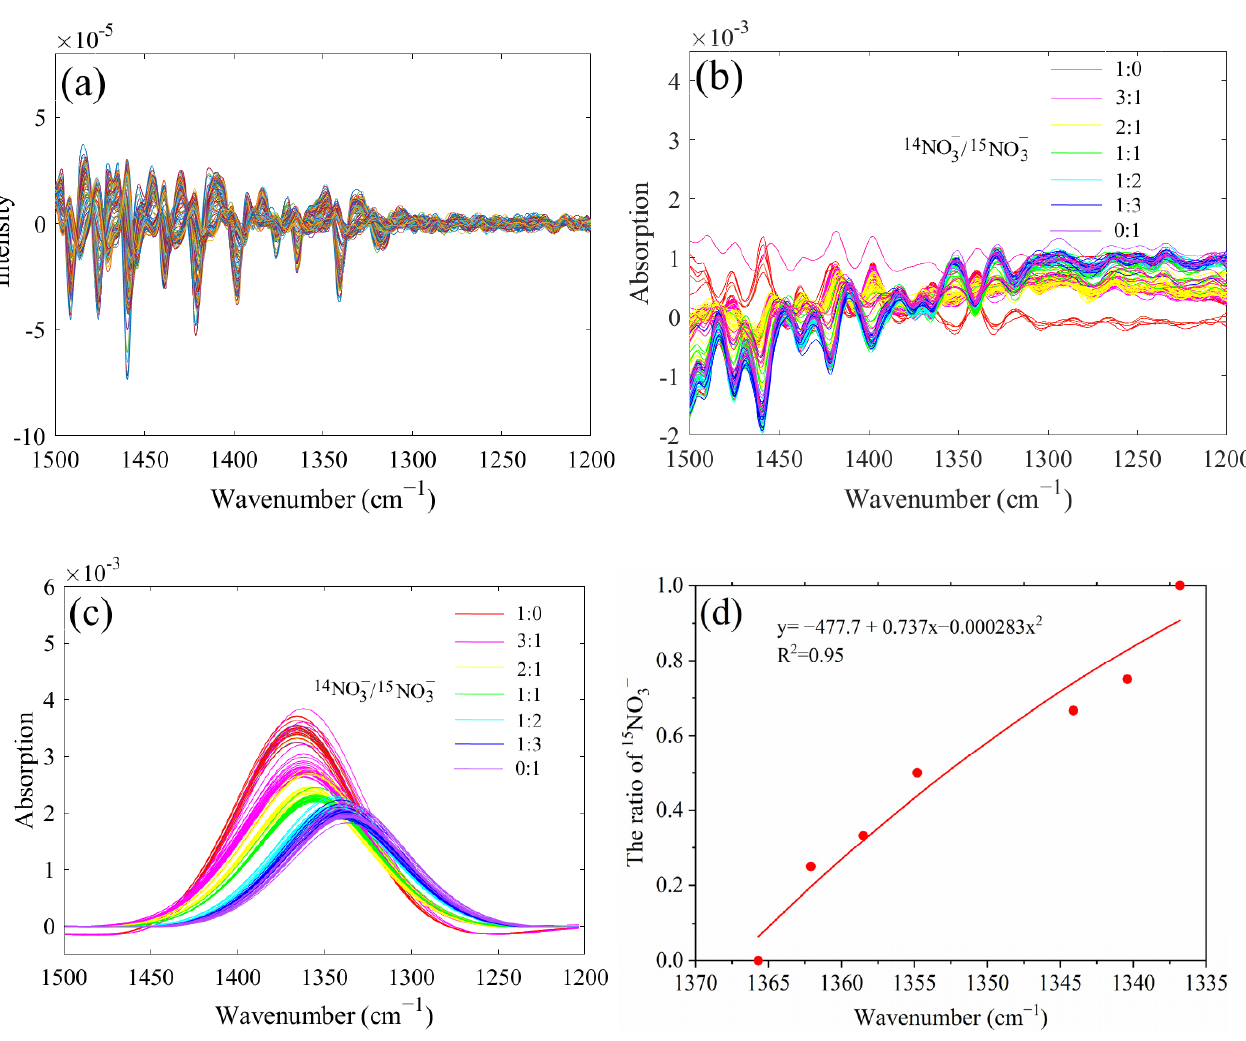
Figure 2. The second derivative spectra of nitrate in the range of 1500 to 1200 cm − 1 ( a ), characteristic absorption bands of nitrate through water deduction ( b ), deconvoluted spectra of 14 NO 3 − and 15 NO 3 − mixtures with different proportions ( c ), the linear correlation between the proportion of 15 NO 3 − and the wavenumber of the nitrate absorption peaks ( d ).